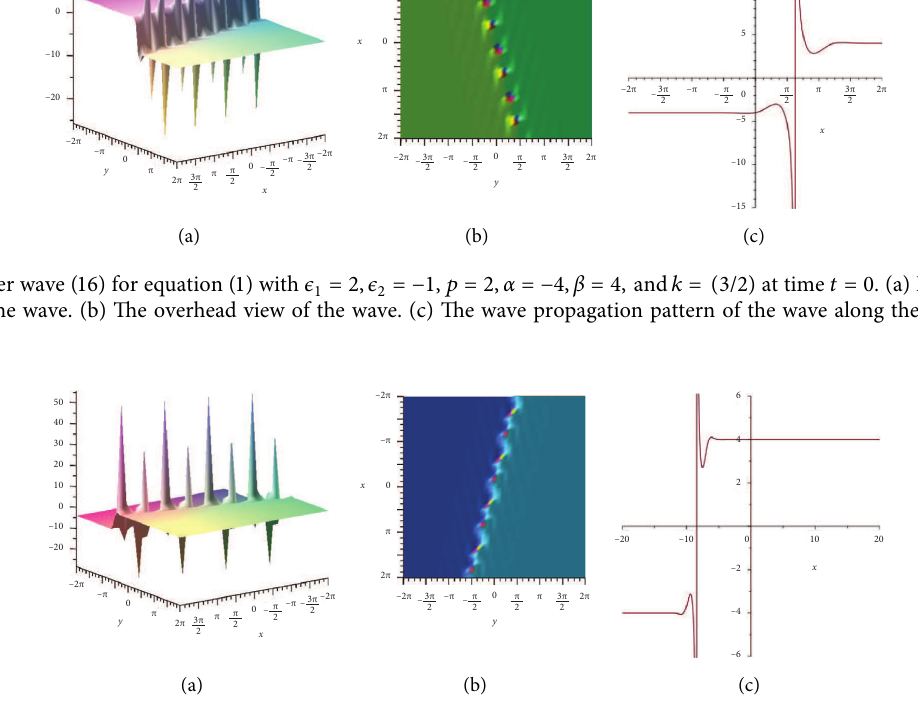
� − 4 , ϵ � − 4 ,p � 2 , α � 4 , β � − 4 , and k � ( 1/2 ) at time t � 0. (a) Perspective view of 1 2